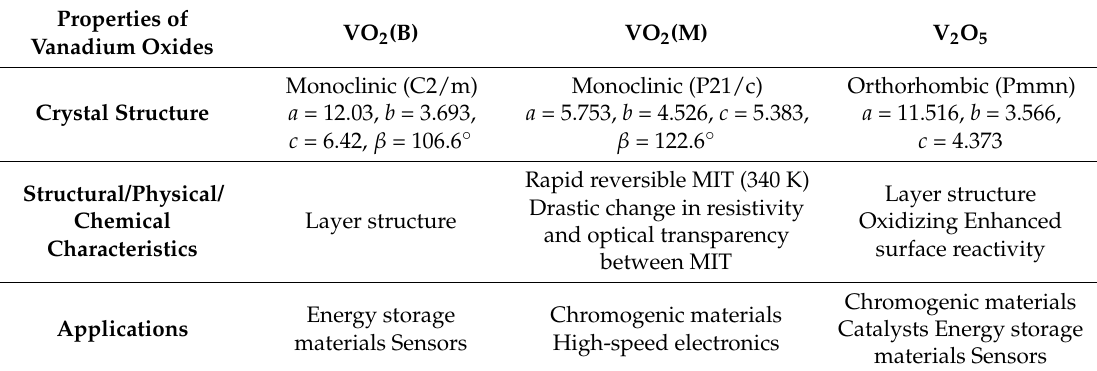
Table 1. Crystal structure, properties, and important applications of VO 2 (B), VO 2 (M), and V 2 O 5 . Properties